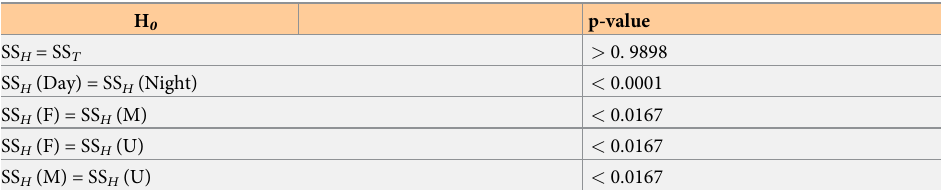
Table 3. Hypothesis tests for typical swim